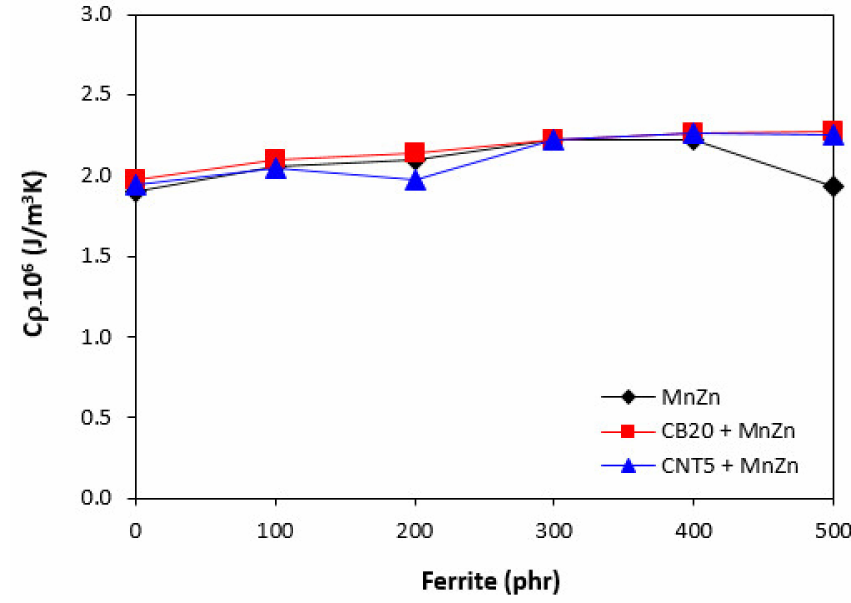
Figure 12. Volumetric heat capacity C ρ of